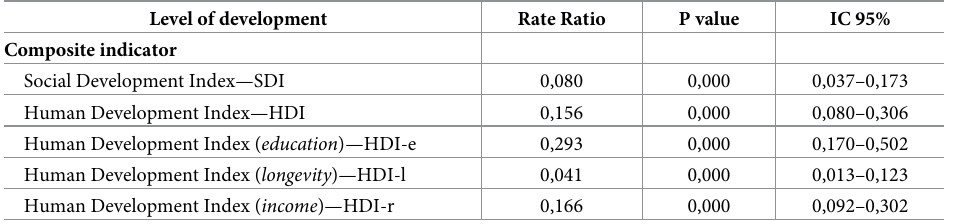
Table 1. Rate ratio of nonadherence with antituberculosis treatment for human and social development indica- tors according to the Poisson regression model.